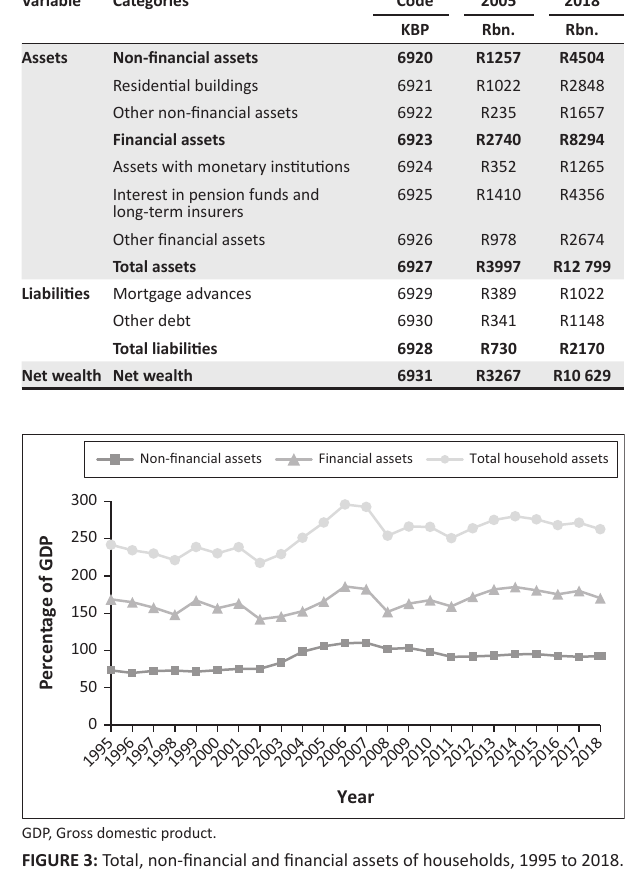
FIGURE 3: Total, non-financial and financial assets of households, 1995 to